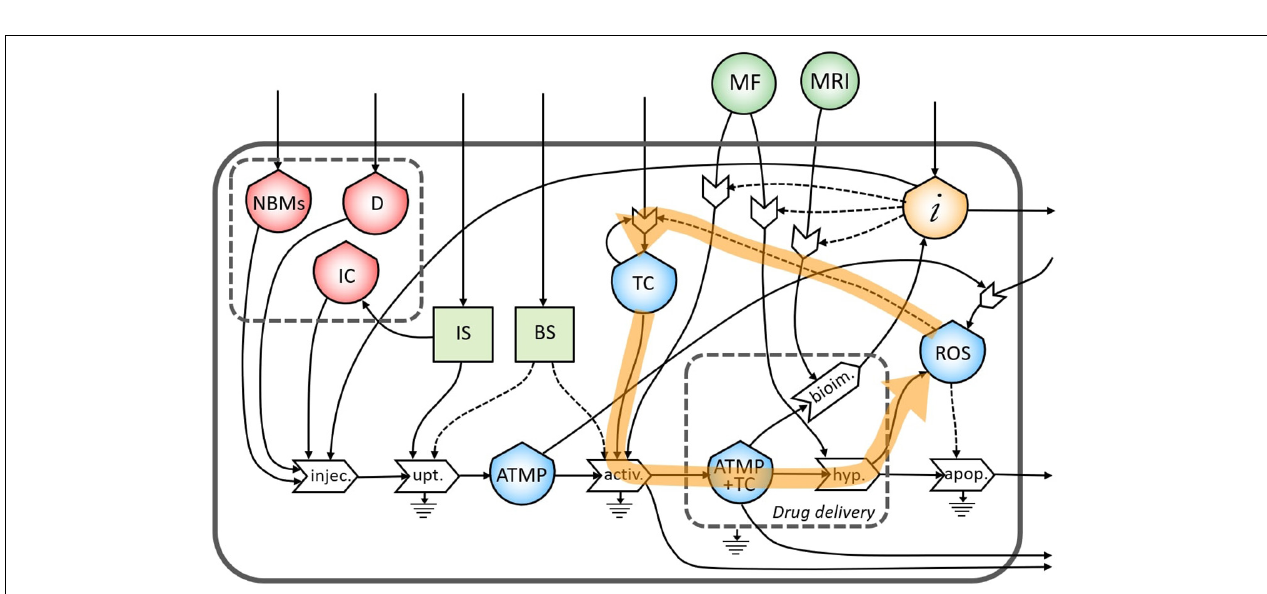
FIGURE 6 | Representation of the feedback loop of the flow of information on the activation process.